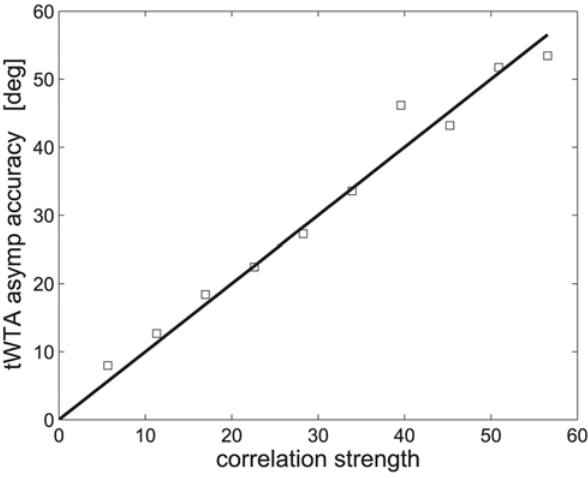
Figure 9. Effect of correlations on the asymptotic tWTA estimation accuracy in a hypercolumn model. tWTA accuracy, in terms of the root mean square estimation error, D h , is shown as a (cid:5) (cid:6) t c 180 , in a hypercolumn function of the correlations’ strength, p t model, as defined in section ‘effect of correlations on the tWTA estimation accuracy’, see equation (34). The solid line shows the analytical asymptotic value, equation (35). Open squares show the numerical estimation of the asymptotic value as calculated by averaging the tWTA estimation error over 100 trials in a hypercolumn model of N ~ 100,000 cells. The latency function that was used was: